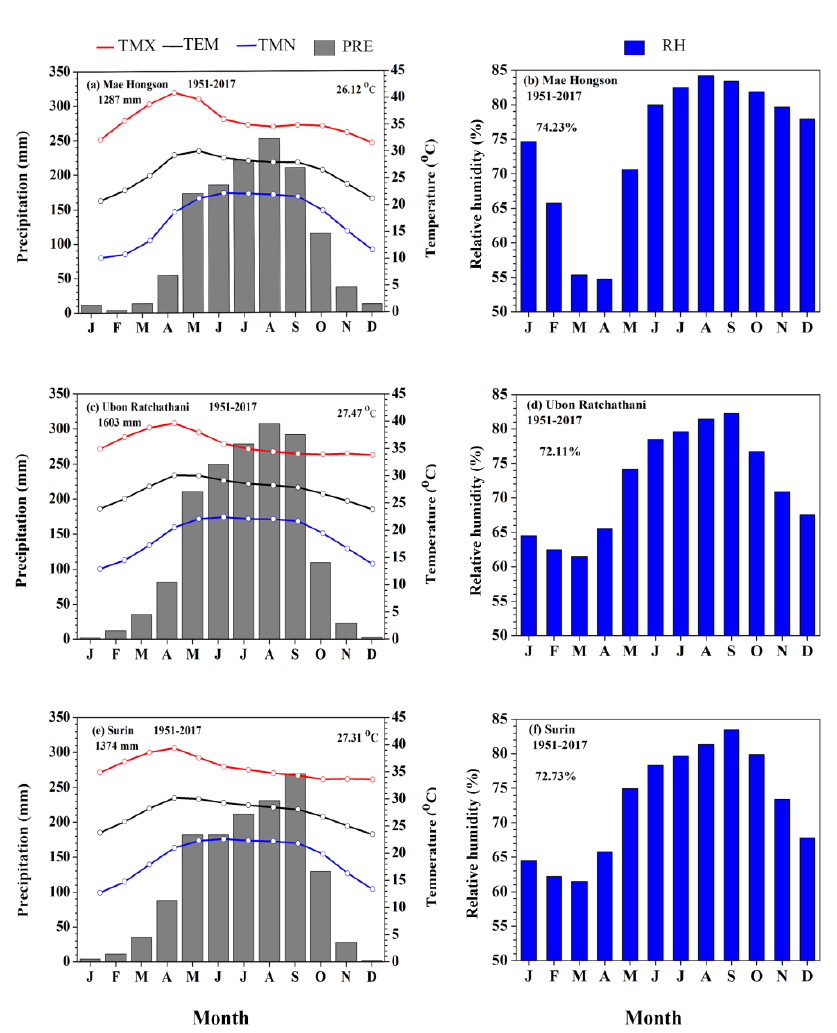
Figure 2. Climate diagrams showing monthly means of minimum (blue line), mean (black line) and maximum (red line) temperature and precipitation (grey bar) and monthly relative humidity (blue bar) between 1951–2017 at Mae Hong Son ( a , b ), Ubon Ratchathani ( c , d ) and Surin station ( e , f ) in Thailand. The capital letters J to D stand for the month’s name, starting from January to December.